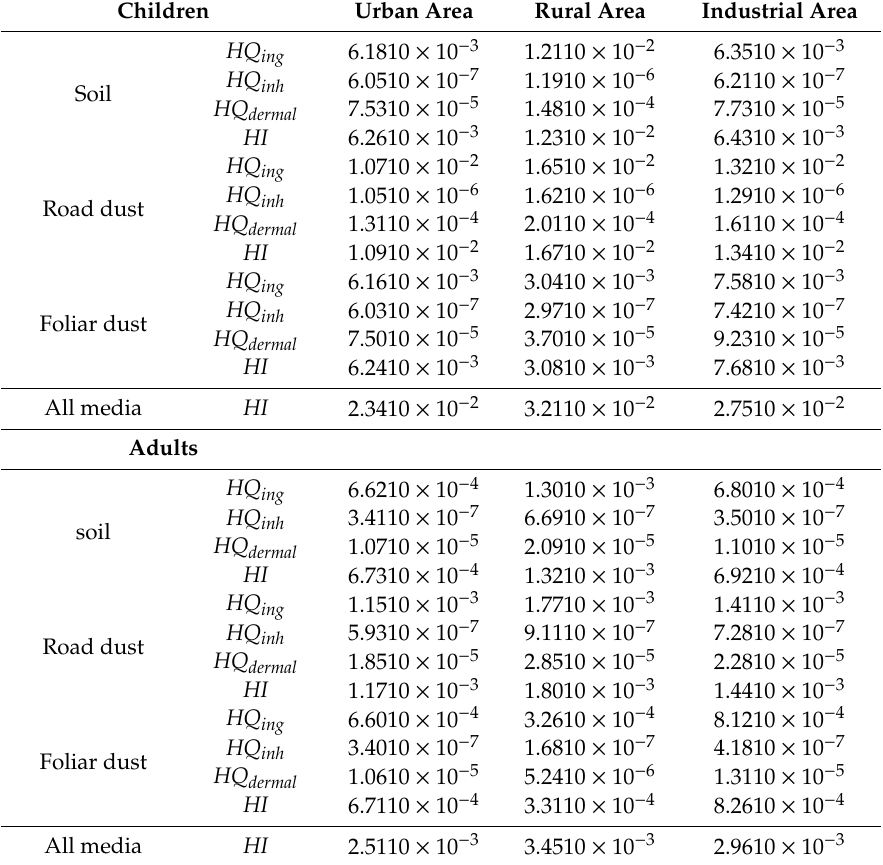
Table 6. Hazard quotient ( HQ ) for di ff erent exposure pathways in soils, dust and foliar dust in di ff erent land-use